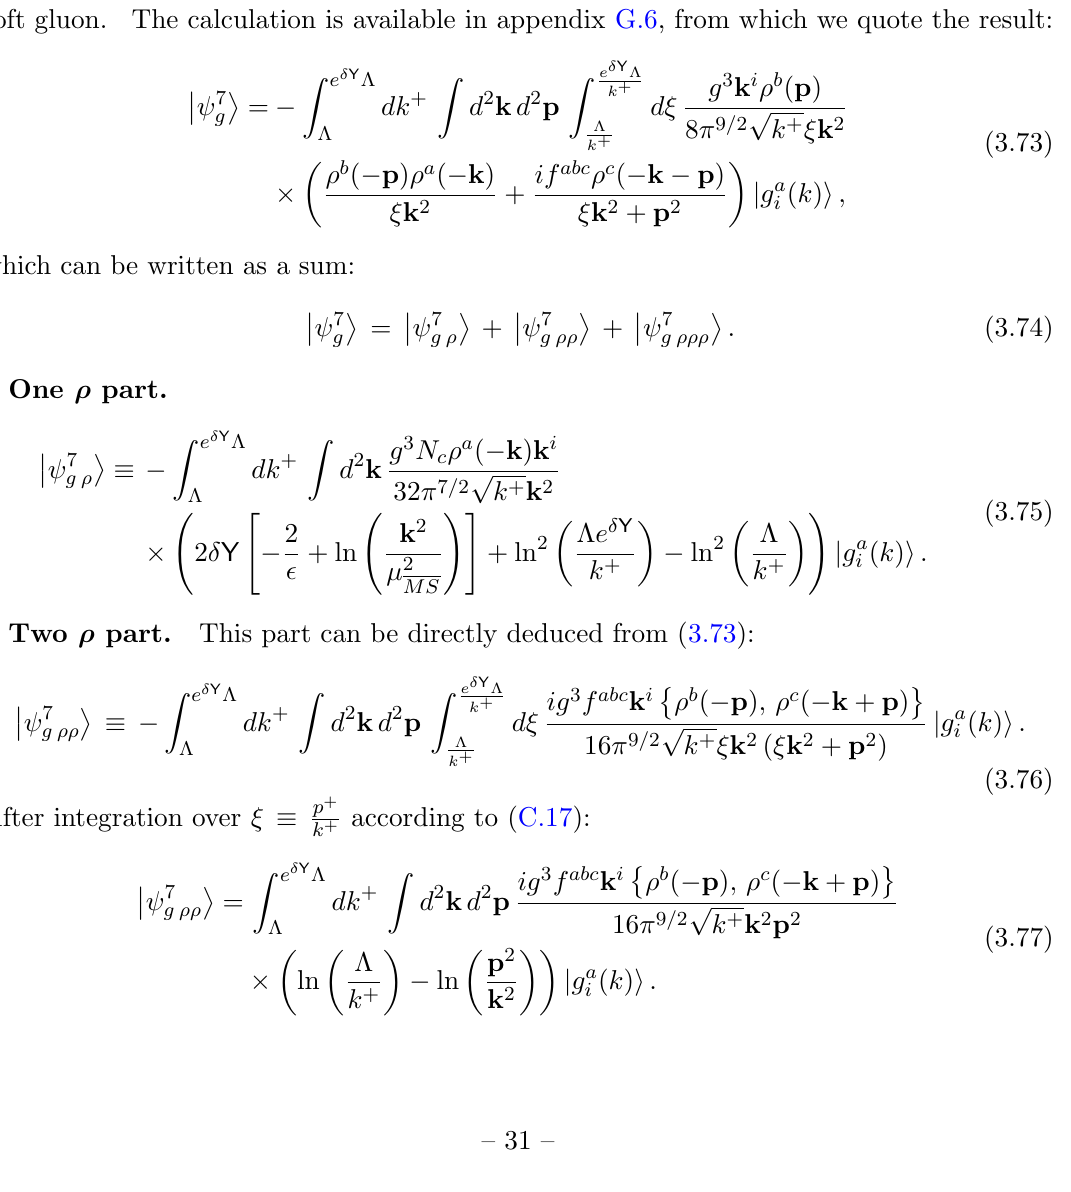
Figure 9 . One gluon production diagrams with contribution to three (cid:26) . (a,b) - (cid:12) (cid:11) accounts for two distinct processes depicted, after the dummy momenta are integrated (cid:12) 7 g over, in (cid:12)gure 9a and (cid:12)gure 9b. They correspond to two di(cid:11)erent light cone orderings